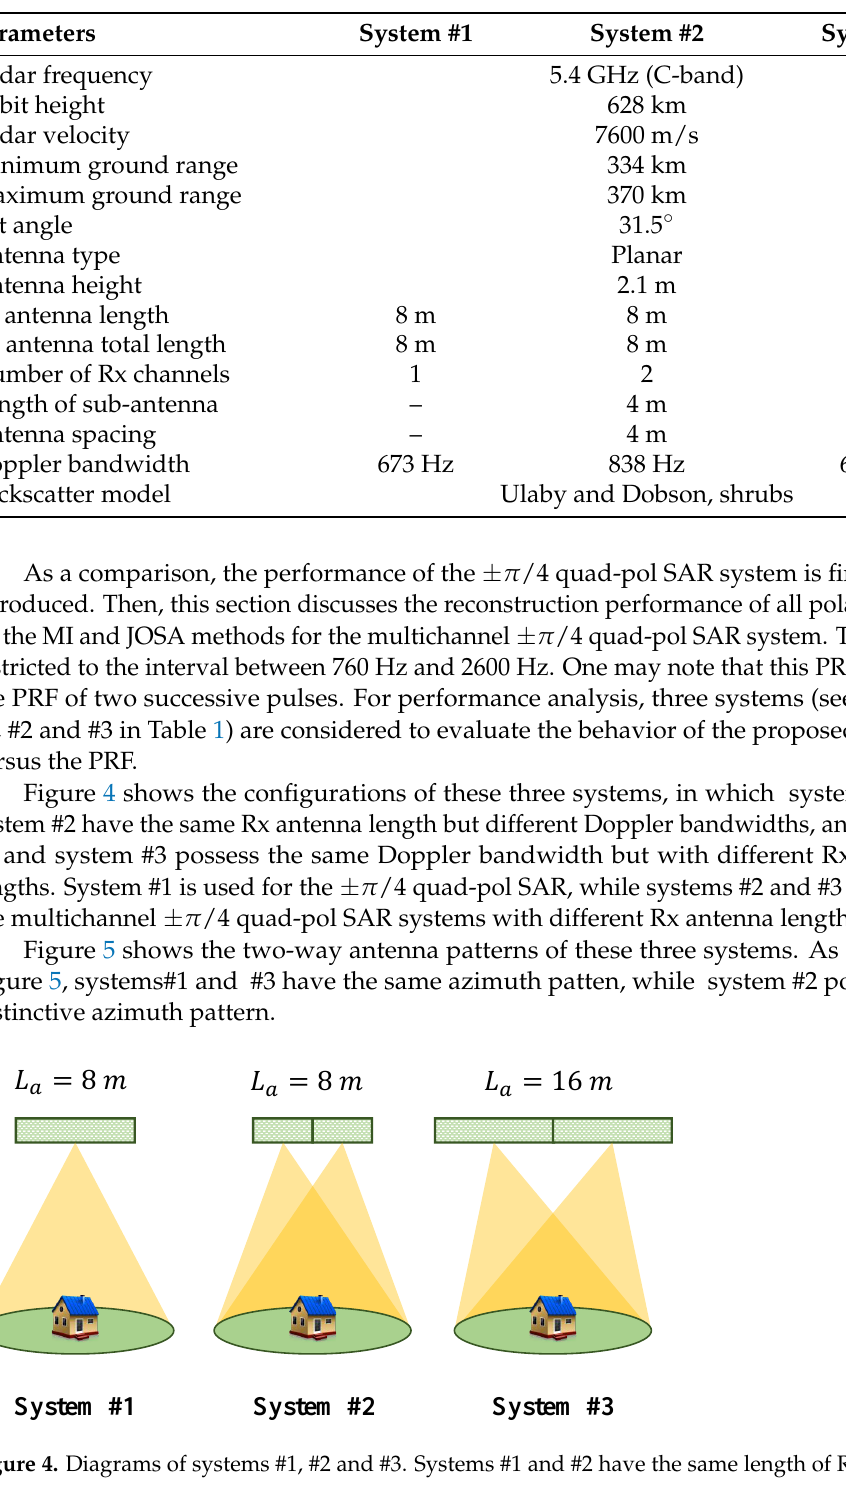
Figure 4. Diagrams of systems #1, #2 and #3. Systems #1 and #2 have the same length of Rx antenna, while systems #2 and #3 have the same number of